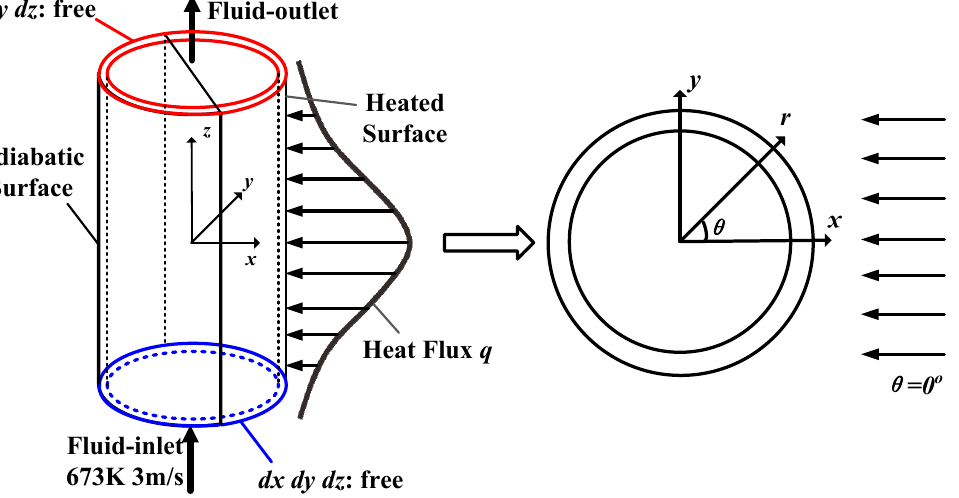
Figure 1. Physical model of the solar receiver